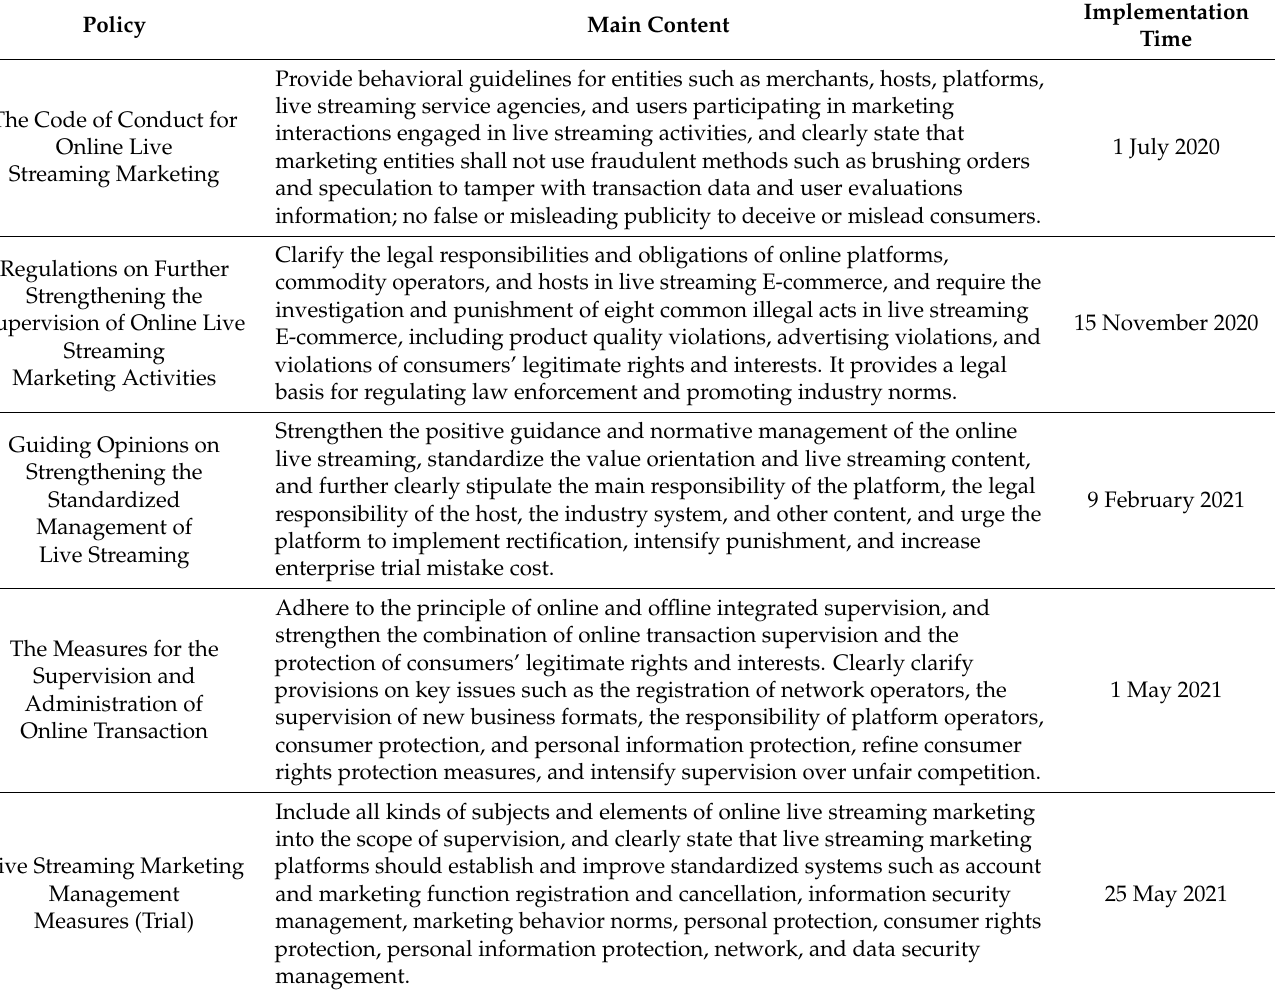
Table 1. Relevant normative policies for the live streaming E-commerce industry.